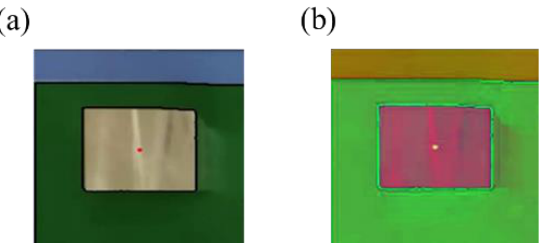
Figure 20. ( a ) Original RGB image of the metal block object on a green-color conveyer belt and ( b ) after being processed by the HSV color model.